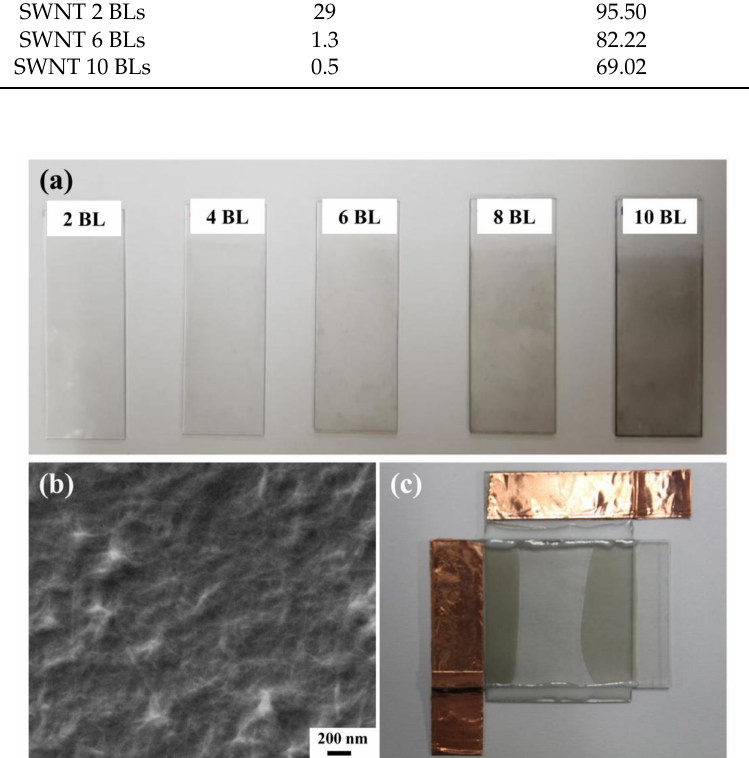
Figure 2. ( a ) Photograph of [PDDA/(SWNT–DOC)] n ( n = 2–10) assemblies on both sides of a glass slide. ( b ) SEM surface image of [PDDA/(SWNT–DOC)] 10 on a poly(ethylene terephthalate) (PET) film. ( c ) Photograph of an LC cell using an SWNT LBL